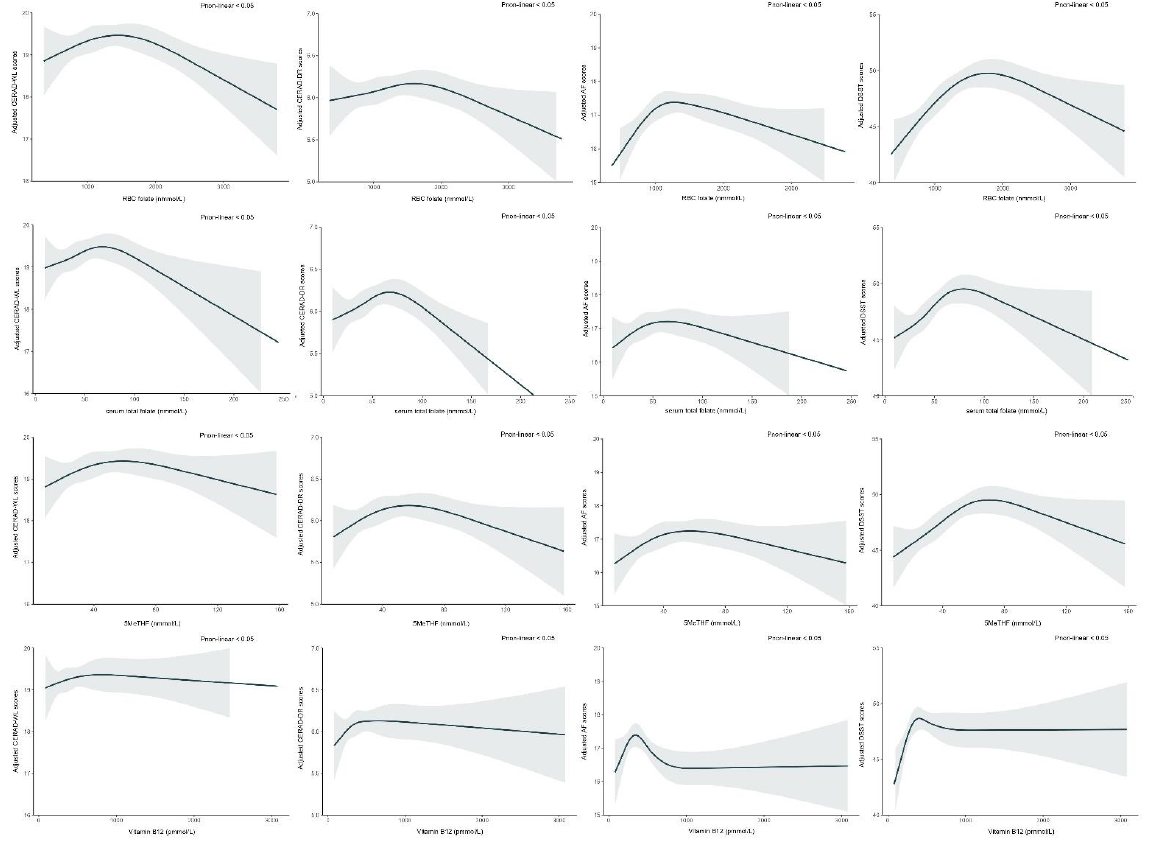
Figure 1. Association between folate/vitamin B12 status and cognitive performance. The associa- tions between the cognitive level and RBC folate, serum total folate, 5MeTHF, and vitamin B12 were assessed by restricted cubic spline curves based on a linear model estimation using ordinary least squares. In Figure 1, the solid black lines with shaded regions indicate the adjusted recognition test scores and their corresponding 95% confidence intervals, respectively.